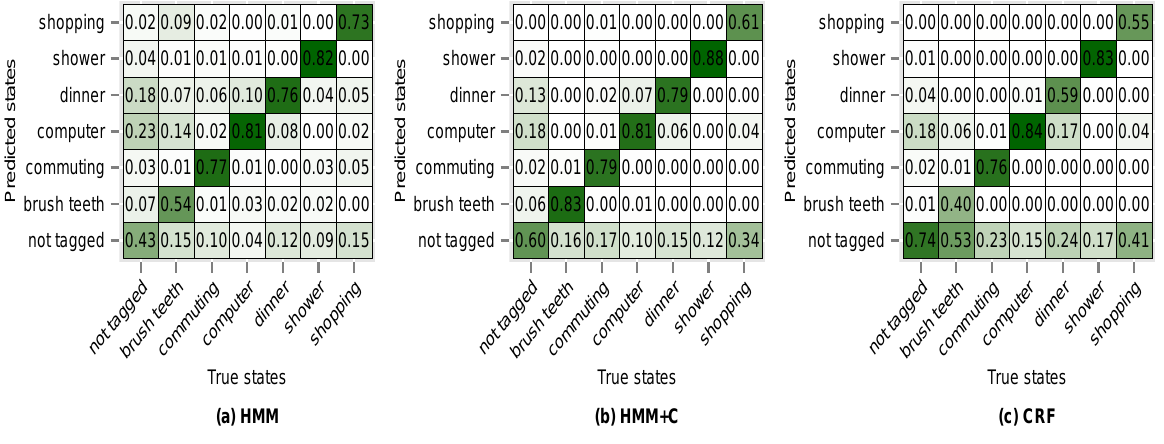
: mean accuracy with no subclassing, 0